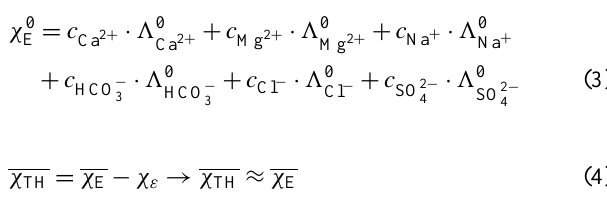
Figure 7. Two typical cyclic voltammetry measurements of di ff er- ent water samples.